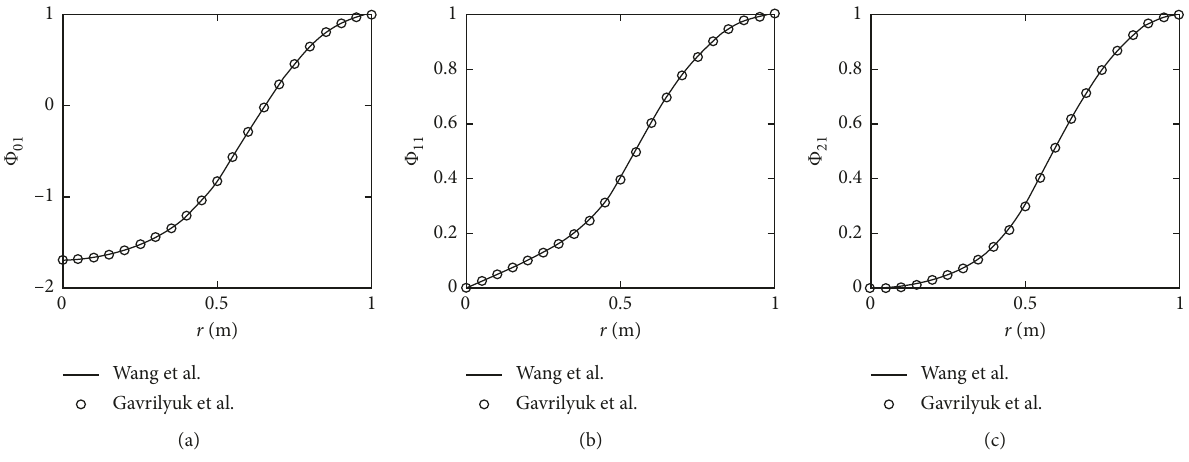
Figure 3: Comparison of the natural modes calculated by Wang et al. [9] and Gavrilyuk et al. [32].